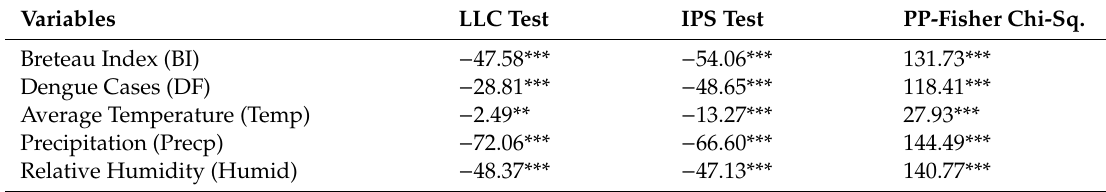
Table A1. Panel unit root test results, using Levin–Lin–Chu test, Im–Pesaran–Shin test and Fisher-PP test at